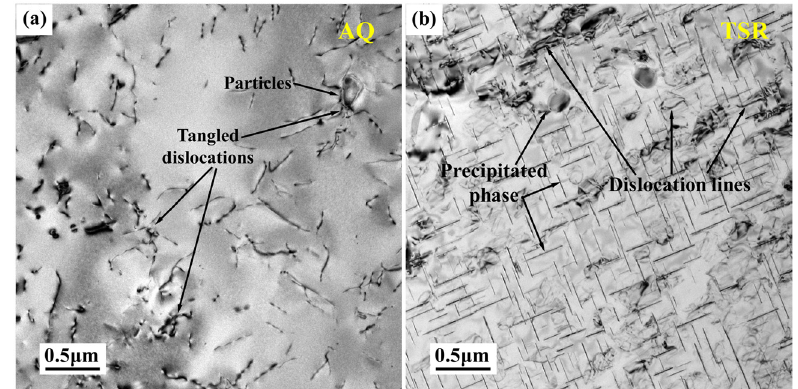
Figure 7: TEM images of dislocation characteristics: ( a ) AQ piece and ( b ) TSR piece.